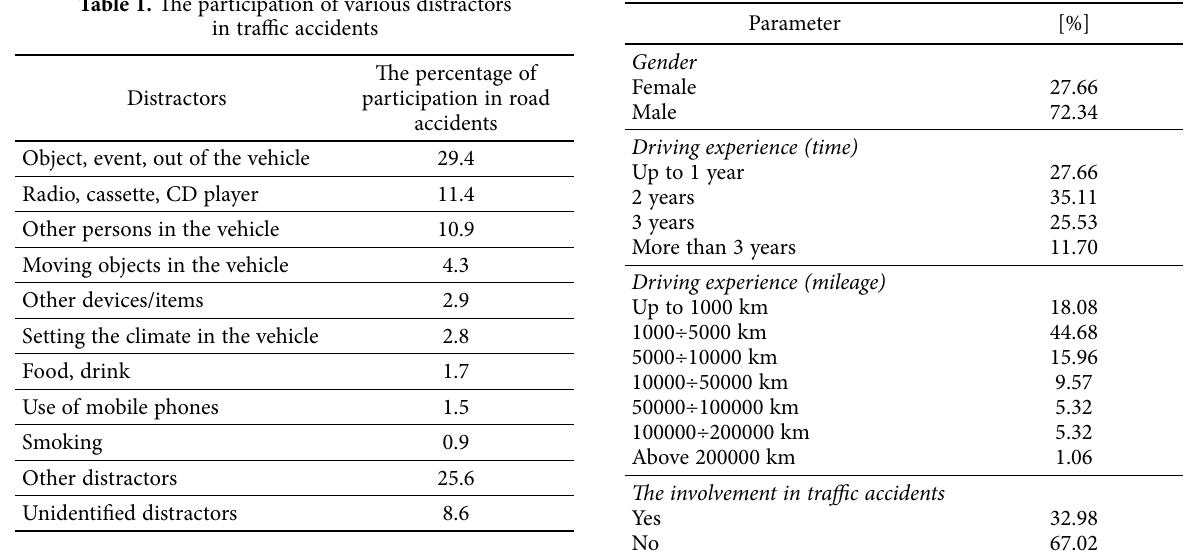
Table 2. General structure of the participants